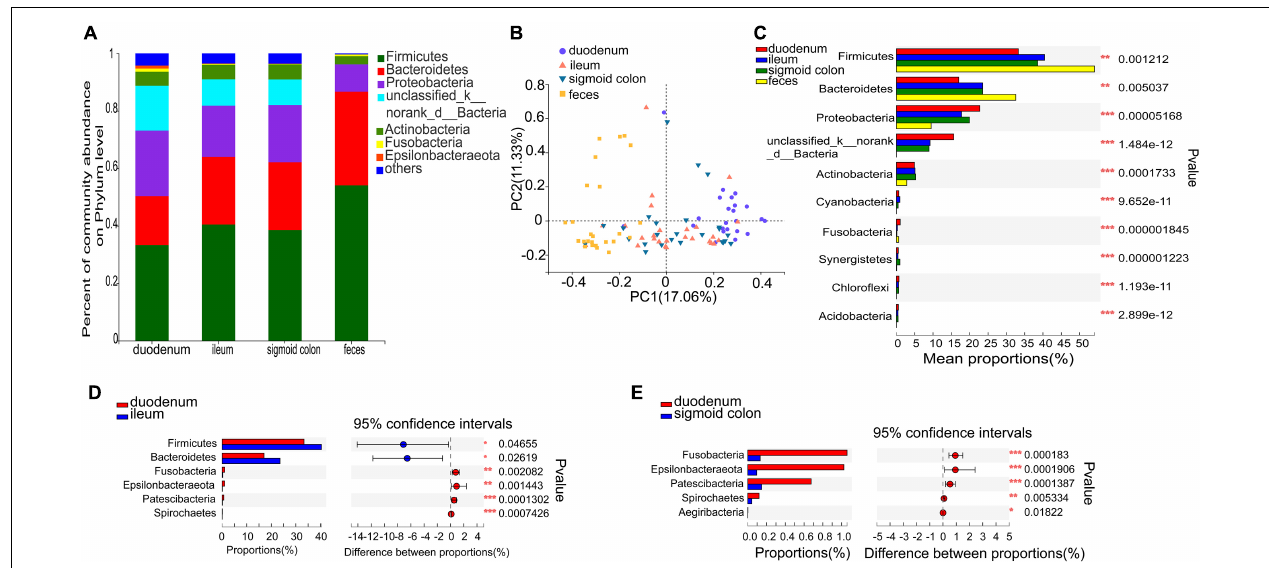
FIGURE 2 | Distinct bacterial composition at the phylum level in the mucosal and fecal samples of all subjects. (A) The predominant phylum in the 4 types of samples. (B) PCoA analysis based on the bray_curtis distance showed that the bacterial composition of the fecal and duodenal mucosal samples were significantly different from the other two groups (ANOSIM R = 0.305, P = 0.001). (C) Firmicutes and Bacteroidetes were significantly enriched ( P = 1.2 × 10 − 3 and P = 5 × 10 − 3 , respectively), while Proteobacteria, unclassified_k_norank_d_Bacteria, and Actinobacteria were significantly lower in the fecal samples compared to the mucosal samples ( P = 5.2 × 10 − 5 , P = 1.5 × 10 − 12 , and P = 1.7 × 10 − 4 , respectively). (D) Firmicutes and Bacteroidetes were significantly lower in the duodenal mucosal samples than in the ileac mucosal samples ( P = 0.047 and P = 0.026, relatively). (E) Fusobacteria, Epsilonbacteraeota, Patescibacteria, and Spirochetes were significantly enriched in the mucosal samples of the duodenum than in the mucosal samples of the sigmoid colon ( P = 1.83 × 10 − 4 , P = 1.9 × 10 − 4 , P = 1.39 × 10 − 4 , and P = 5.33 × 10 − 3 , respectively). The phyla with < 0.1% abundance were aggregated as “others.” The Kruskal–Wallis H test was used to test differences among multiple groups with fdr controlling the false discovery rates. Wilcoxon rank-sum test was used to test differences between two groups. * P < 0.05, ** P < 0.01, and *** P <